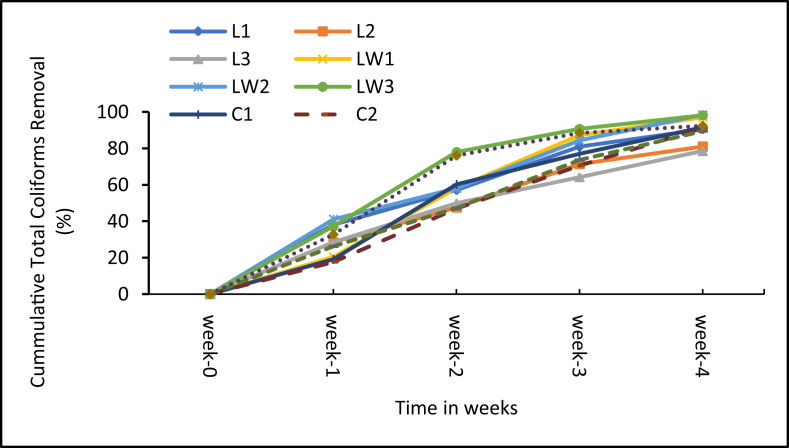
Mean Total Coliform percentage removal. Note: L1 = 25 mL stock LSEC, L2 = 50 mL stock LSEC, L3 = 75 mL stock LSEC, LW1 = 0.1% DF, LW2 = 0.5% DF, LW3 = 1% DF, C1 = 5 g calcium carbide, C2 = 8 g calcium carbide, C3 = 10 g calcium carbide, CN = control.